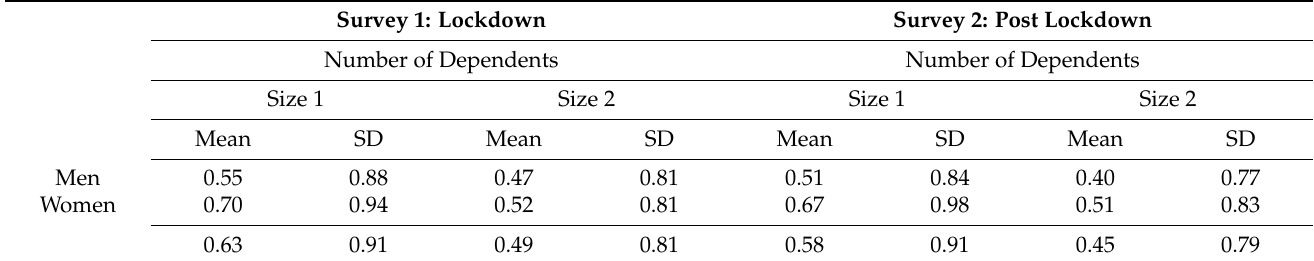
Table 7. Mean and standard deviations (SD) of number of dependents being cared for by gender in each of the groups